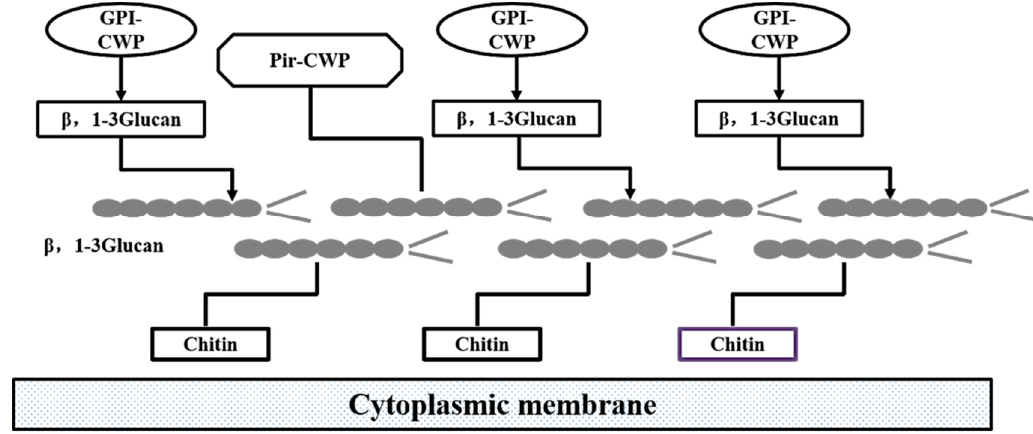
Figure 1. Composition of the yeast cell wall.